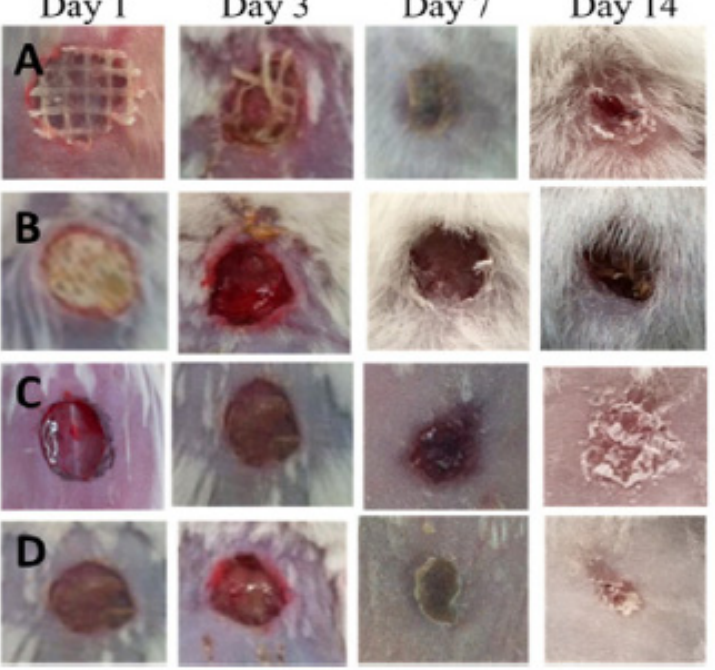
Figure 7. Photographic images on days 1, 3, 7, and 14 of wounds treated with petrolatum gauze ( A ), nano silver dressing ( B ), BC ( C ), and BC-Vac ( D ) membranes. Adapted with permission from the authors of [110]. Copyright 2015 Elsevier.